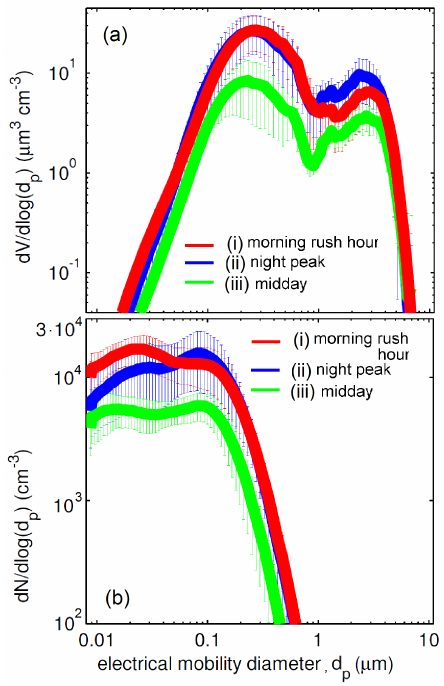
Figure 12. Average particle size distribution based on ( a ) volume and ( b ) number concentration measured during ( i ) the week-day morning rush hour; ( ii ) the week-day night peak; and ( iii ) the weekend midday.